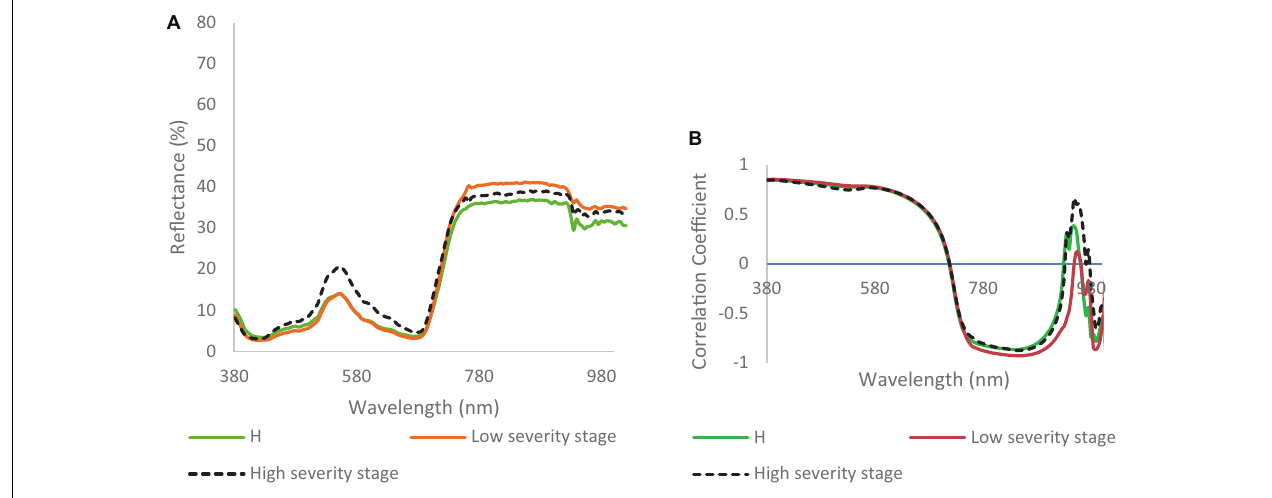
FIGURE 5 | (A) Spectral reflectance signatures developed from hyperspectral imaging collected in the field; and (B) correlation coefficient for watermelon plant in healthy (H), low, and high downy mildew severity stages.